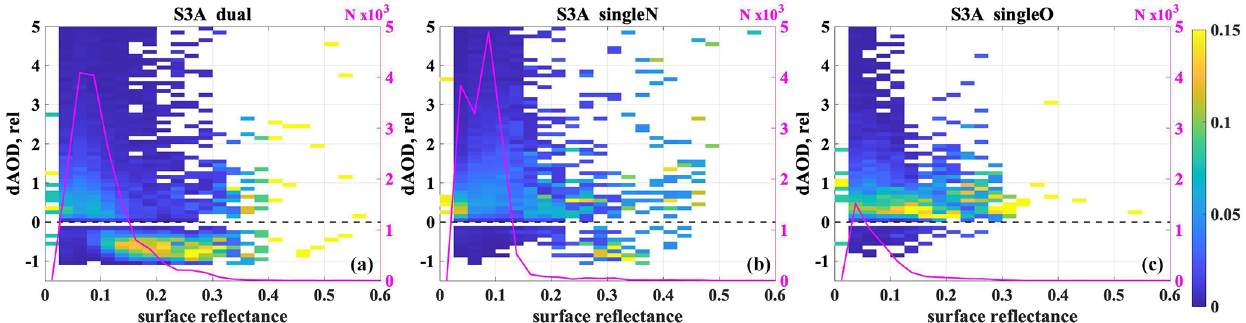
Figure 10. For S3A syAOD matchups with AERONET which do not satisfy GCOS requirements, scatter density plot for the dependence of the syAOD relative offset of retrieved surface reflectance for all (a) , dual (b) , and singleN (c) groups of pixels. Colour indicates the fraction of the points with a corresponding dAOD,rel interval from the total number of points within the surface reflectance bin. The magenta line shows the total number of matchups in the corresponding surface reflectance